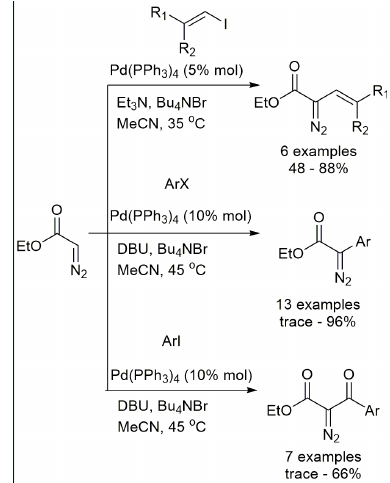
Figure 54 - Palladium-catalyzed cross-coupling of vinyl or aryl iodides/ Carbonylative coupling of aryl Iodides with ethyl